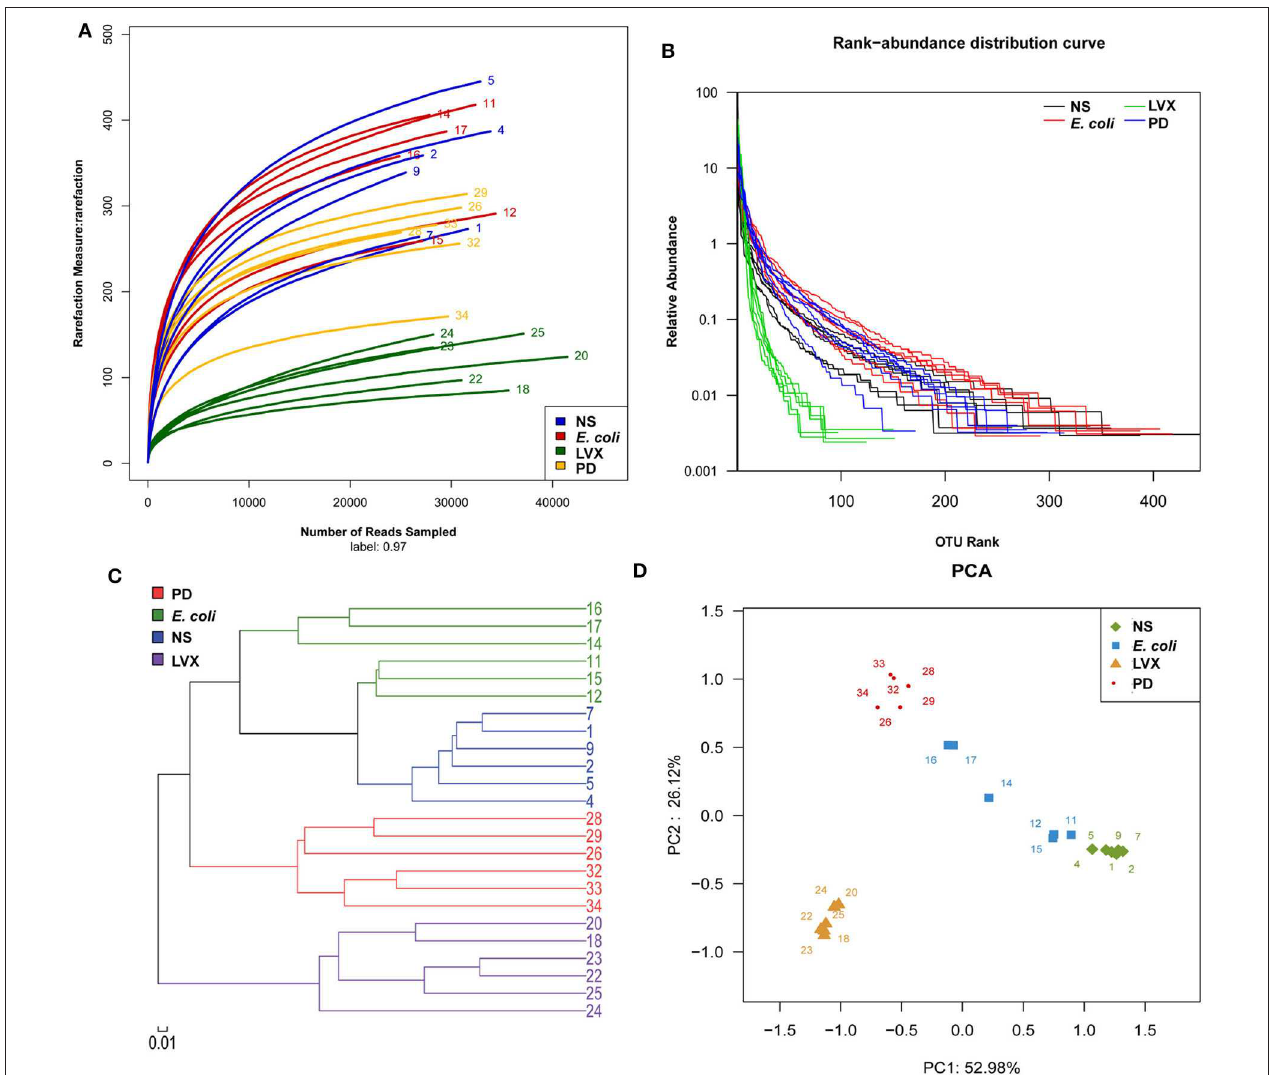
FIGURE 3 | Overall structural and modulation of gut microbiota after PD or LVX treatment. (A) The richness and diversity of rats’ fecal microbiota among four groups. Rarefaction curves were used to estimate richness (at a 97% similarity level) of rats’ fecal microbiota. (B) Rank abundance curve was used to estimate the abundance and evenness. (C) Difference and similarity of microbial communities among four groups revealed by Weighted Uniface principal component analysis (PCA). (D) Hierarchical cluster